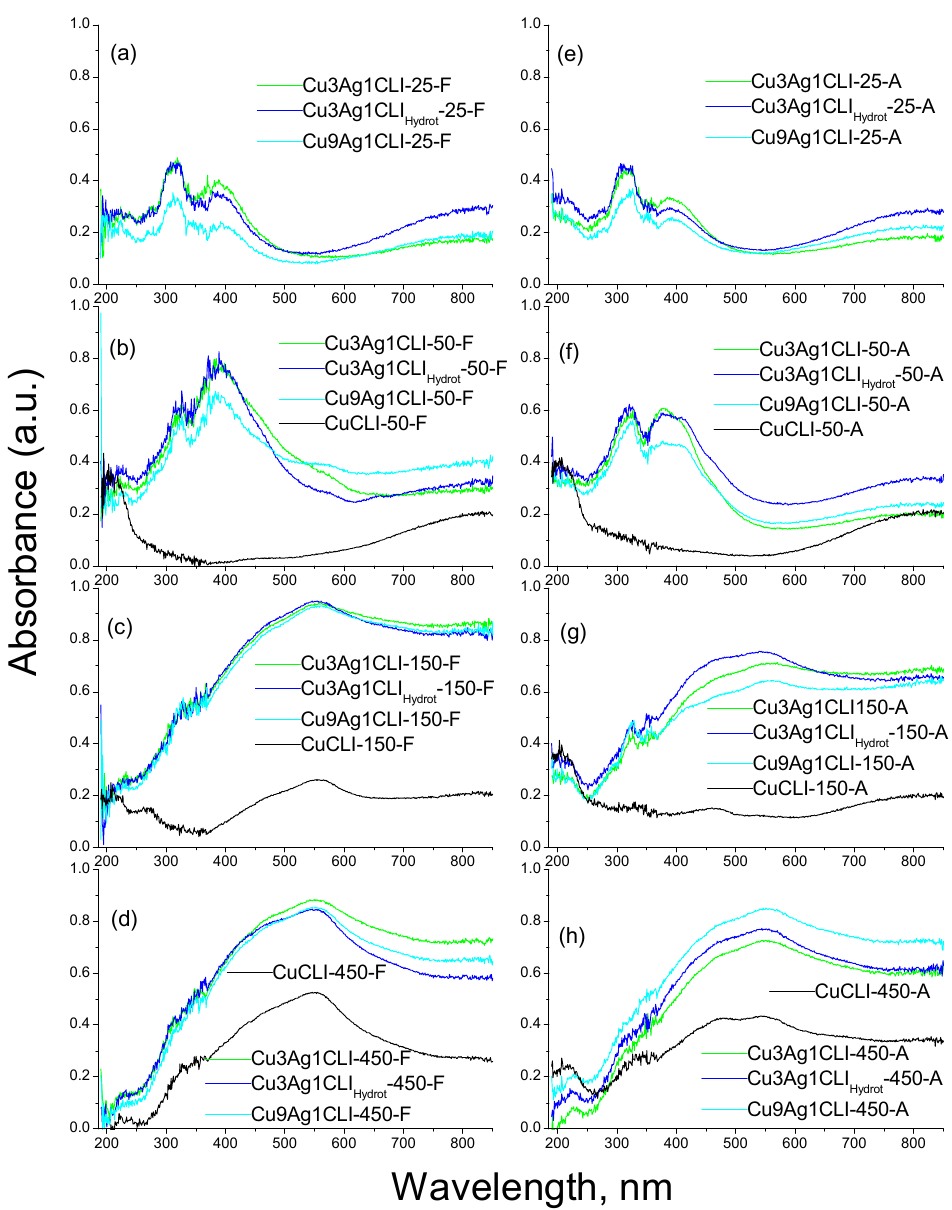
Figure 2. Subtractive spectra of the samples reduced at different temperatures, showing differences in optical density between the fresh ( a – d ) and aged ( e – h )